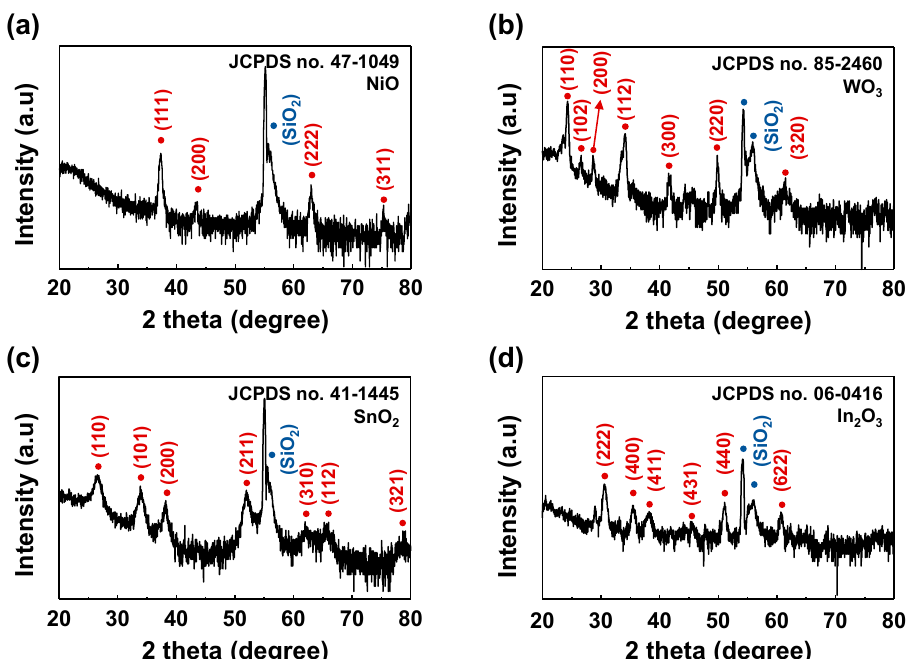
Figure 3. X-ray diffraction pattern of the ( a ) NiO; ( b ) WO 3 ; ( c ) SnO 2 and ( d ) In 2 O 3 .